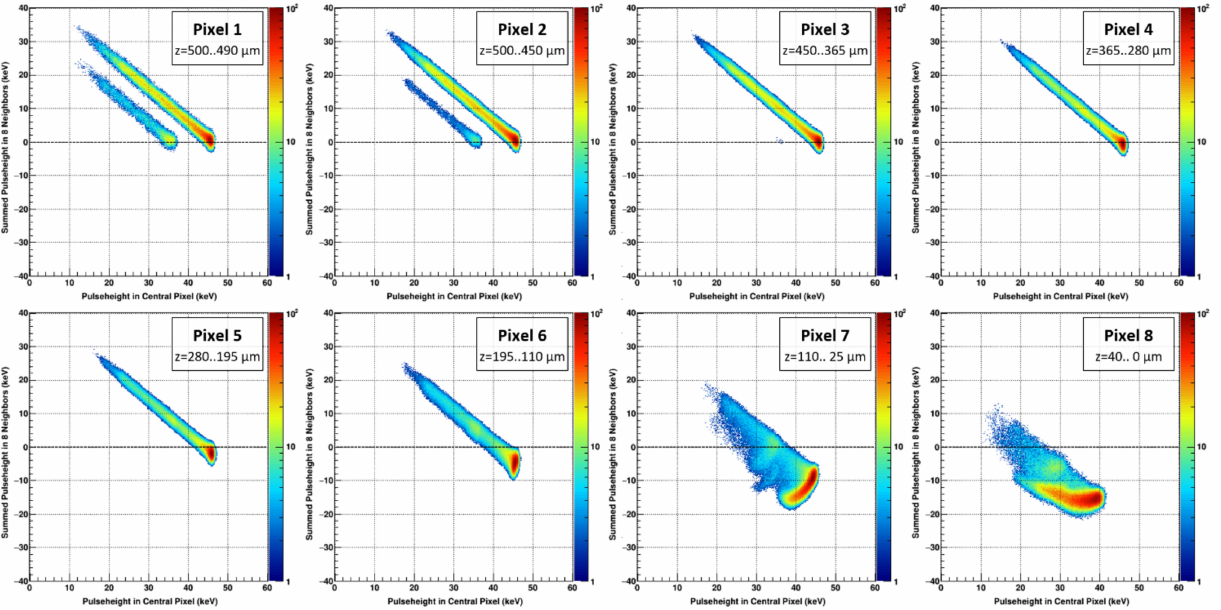
Figure 11. Simulated data of 45 keV photons absorbed at different absorption depths of the sensor (according to the depth bins of the experimental data in Figure